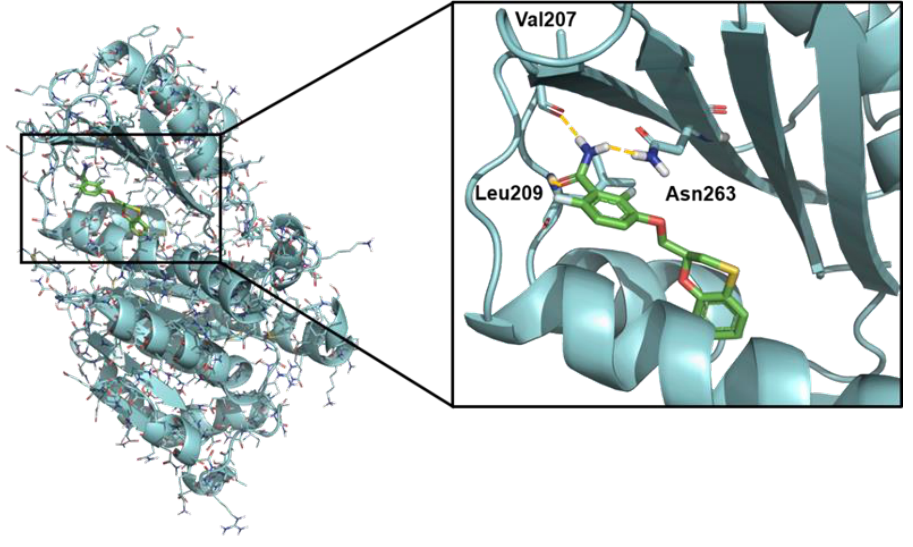
Figure 5. Docking results for compound 1 (depicted in green) in the FtsZ protein (cyan), full protein view and detailed view of the binding site and main ligand-protein interactions.